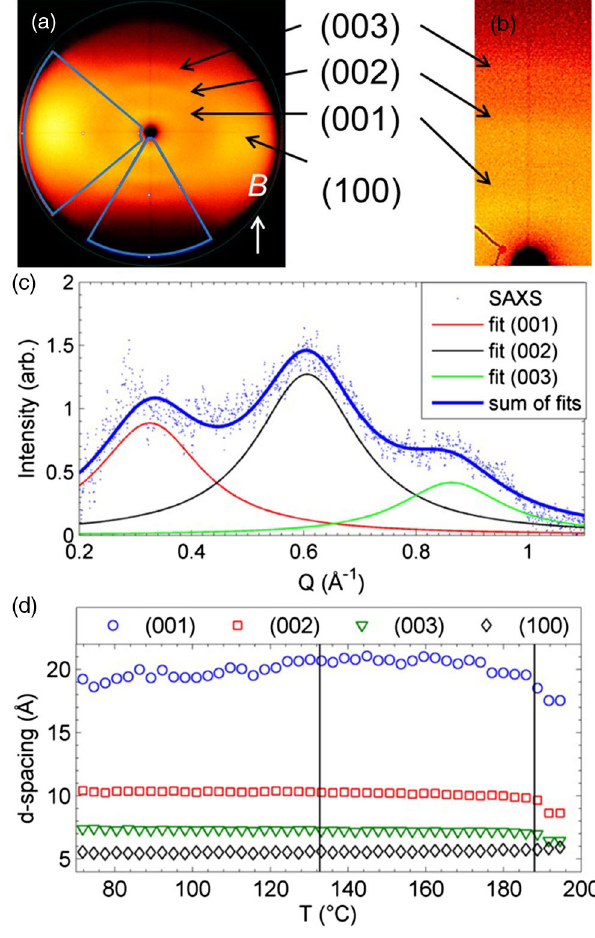
phase at S FIG. 10. Structure of RM734 in the solid state displayed as a thermal ellipsoid model (50% probability), obtained via x-ray diffraction as described in the text and Appendix D. The unit cell ¯1 (space group P ) is indicated. Dashed lines correspond to nitro- nitro close contacts, as described in the